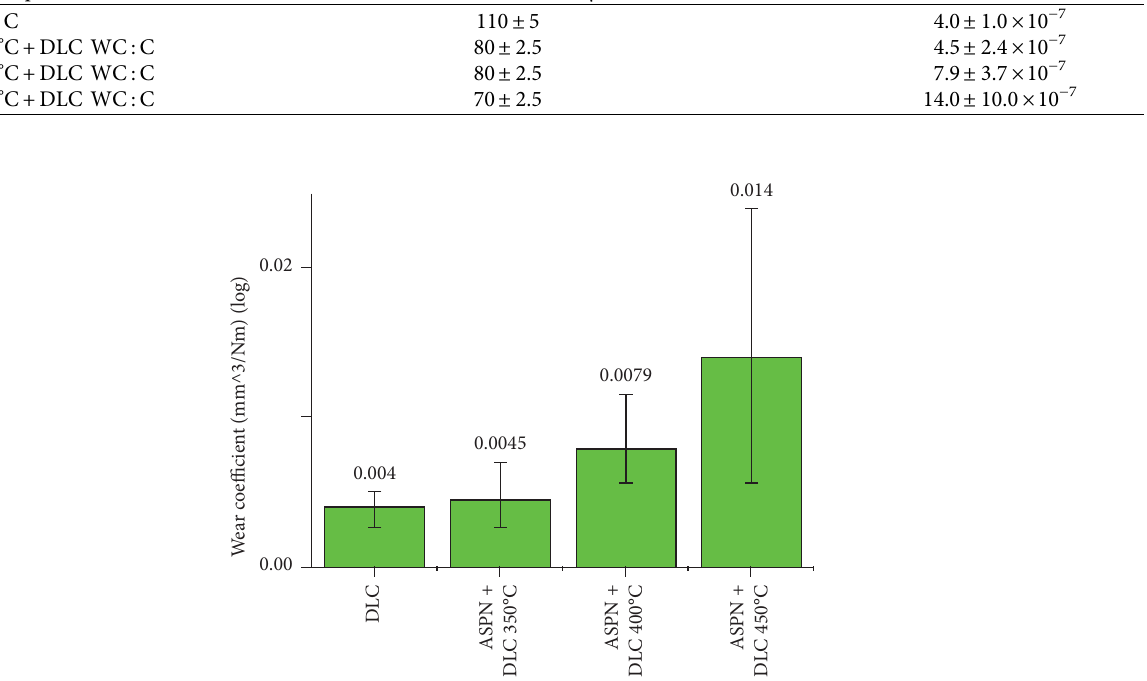
Figure 9: Daimler–Benz rockwell-C adhesion test chart of DLC (a), ASPN 350 ° C+ DLC (b), ASPN 400 ° C+DLC (c), and ASPN 450 ° C+ DLC (d). Table 2: Summary of the experimental data of volume loss and wear coefcient measured by confocal microscopy. Types of samples